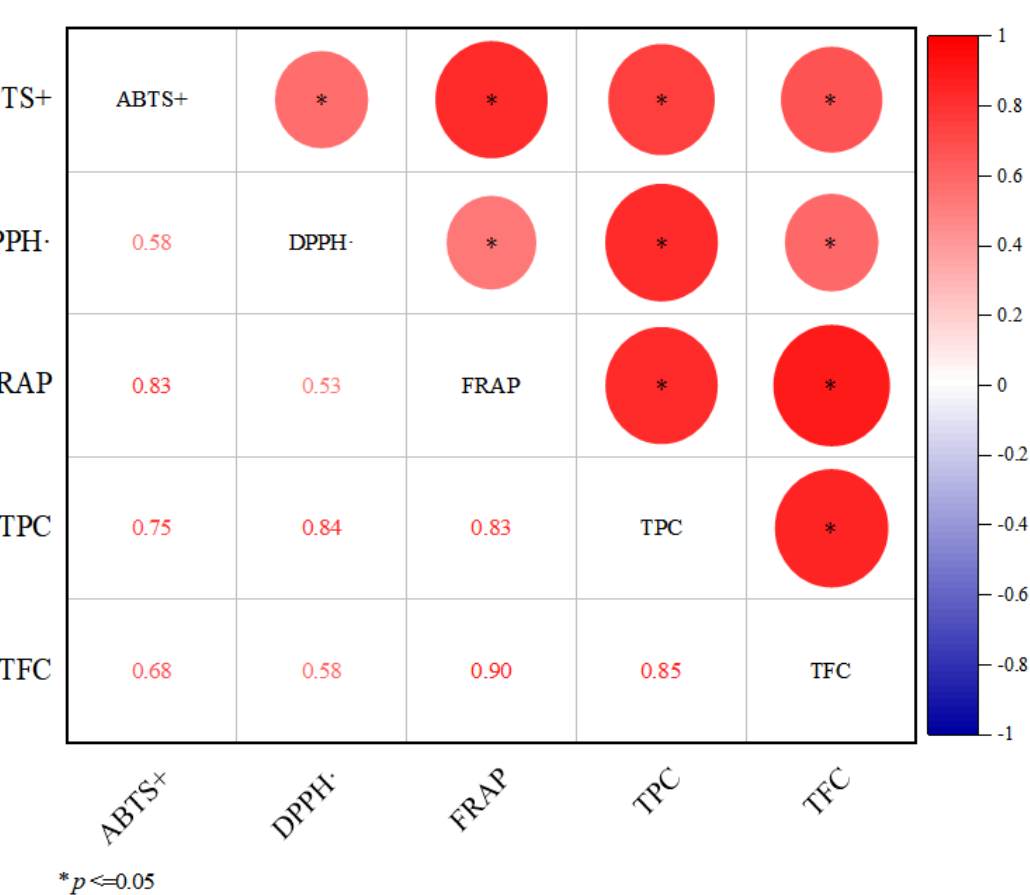
Figure 3. Correlation analysis of TPC, TFC and antioxidant activity of sweetpotato blades. Note: The circle size represents the correlation size. The shade of red represents the size of the positive correlation.